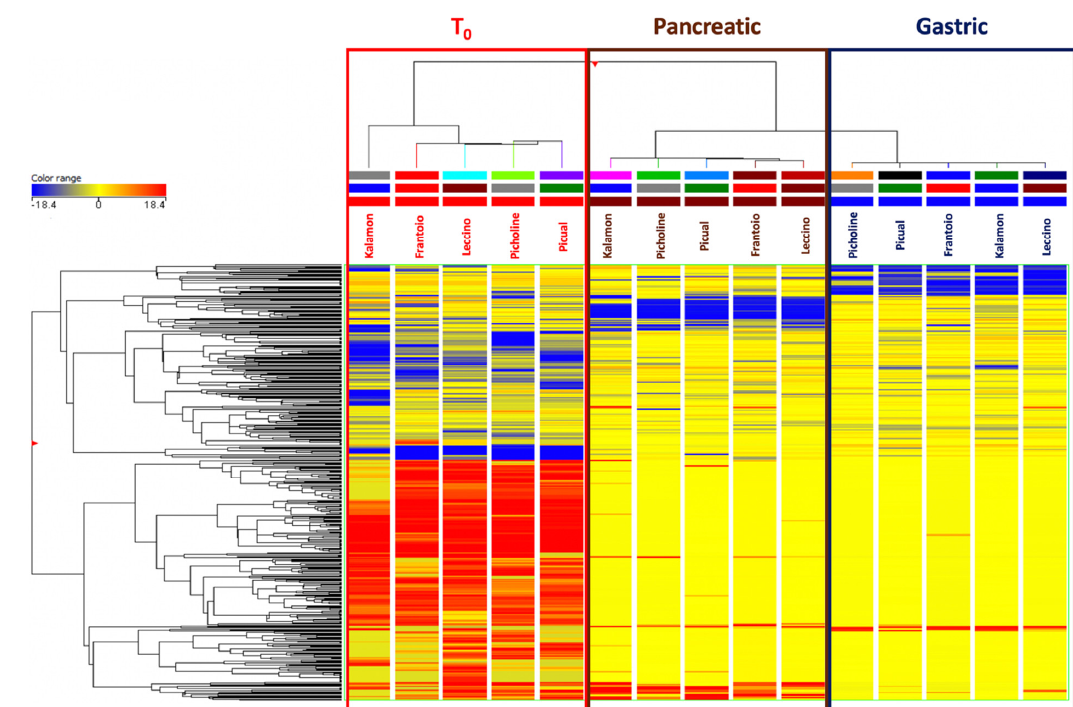
Figure 1. Unsupervised hierarchical cluster analysis (HCA) for the phytochemical profile of different Extra-Virgin Olive Oil (EVOO) samples T 0 (raw; prior to digestion), gastric and pancreatic phases of in vitro gastrointestinal digestion. The cluster was built by considering the fold-change heat-map (similarity: Squared Euclidean; linkage rule: Ward). The color range represents the fold-change values used to build the heat-map.